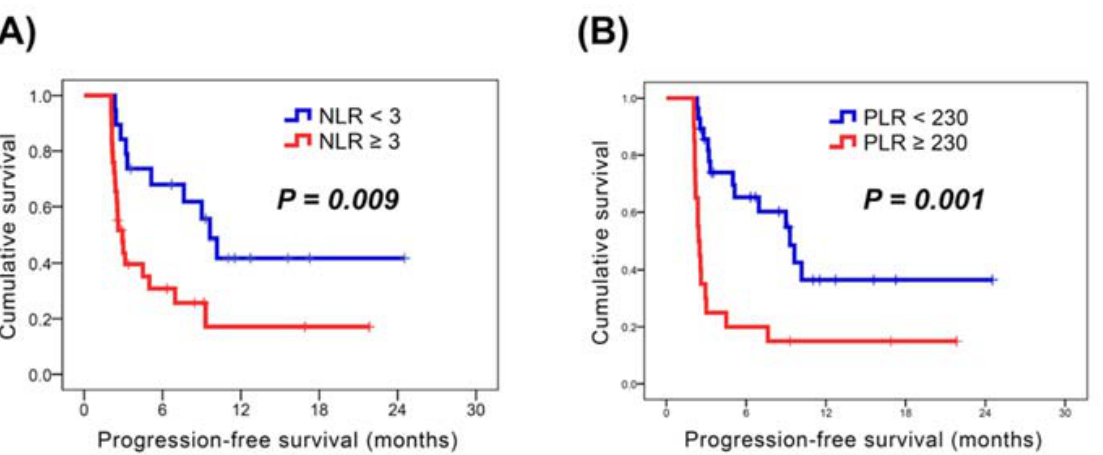
Figure 3. Kaplan–Meier survival analyses ( A ) Kaplan–Meier survival curves for patients with NLR ≥ 3 vs. those with NLR < 3; ( B ) Kaplan–Meier survival curves for patients with PLR ≥ 230 vs. those with PLR < 230.